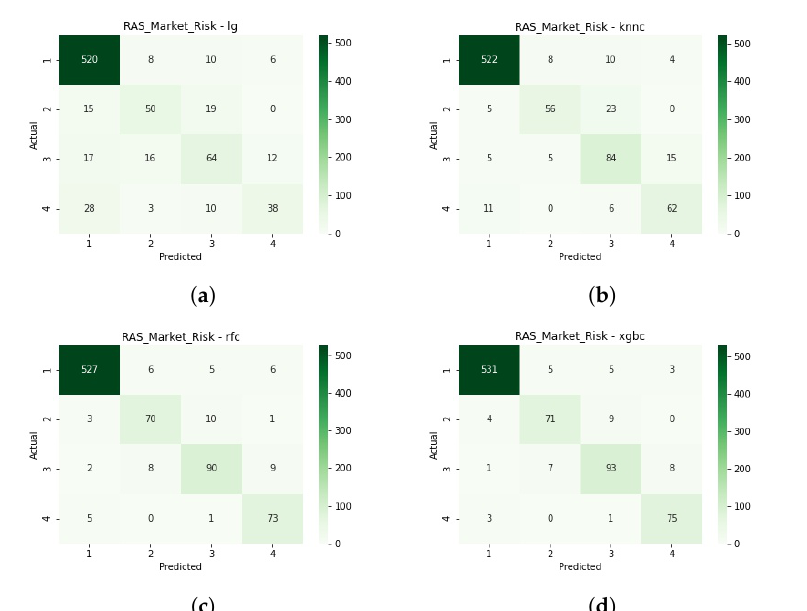
Figure A3. Market risk: confusion matrices generated when evaluating the above-mentioned mod- els, using train-test split approach. ( a ) Logistic Regression. ( b ) k-Nearest Neighbours classifier. ( c ) Random Forest classifier. ( d ) Extreme Gradient Boosting classifier.